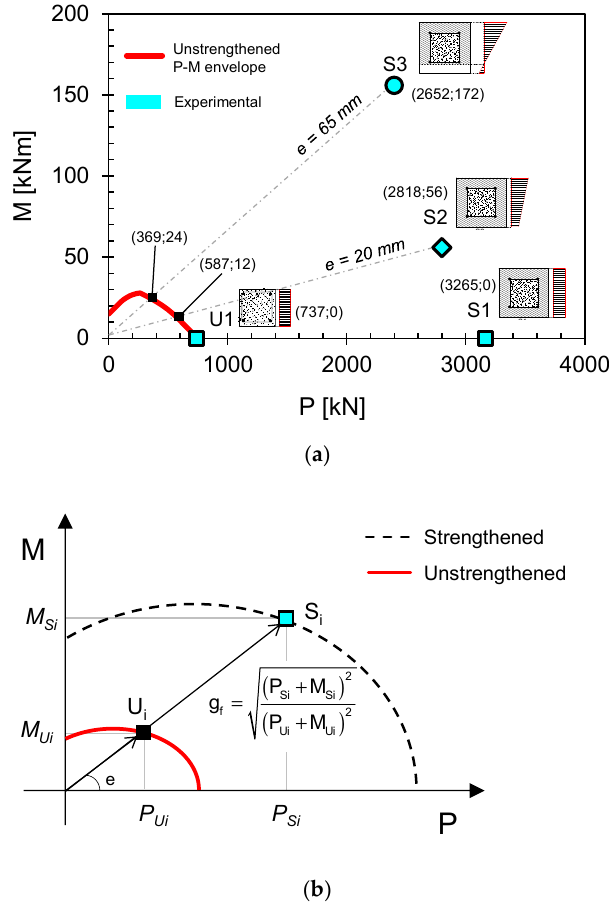
Figure 7. Axial force–bending moment (P-M) diagram ( a ) and gain factor definition ( b ).